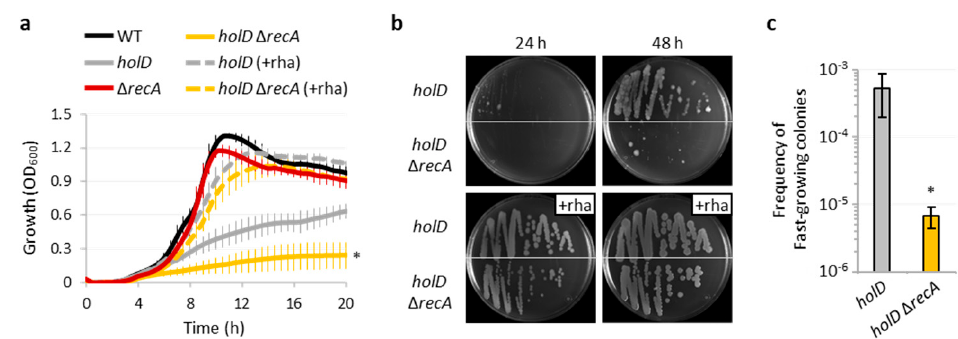
Figure 4. RecA is crucial for the residual growth of HolD-depleted P. aeruginosa cells. ( a ) Growth curves of the P. aeruginosa wild-type (WT) strain PAO1, the holD conditional mutant ( holD ), the ∆ recA mutant, and the holD ∆ recA conditional mutant at 37 ◦ C in MH supplemented or not with 0.01% rhamnose (+rha). ( b ) Growth of PAO1, holD , ∆ recA , and holD ∆ recA strains on MH agar plates supplemented or not with rhamnose after 24 and 48 h of incubation at 37 ◦ C. ( c ) Frequency of fast-growing colonies obtained on MH agar plates without rhamnose for the holD and holD ∆ recA conditional mutants. Data are the mean ( ± SD) of at least three independent assays. The asterisks indicate a statistically significant difference ( p < 0.05) between the holD and holD ∆ recA conditional mutants. The images in panel ( b ) are representative of several experiments giving similar results.